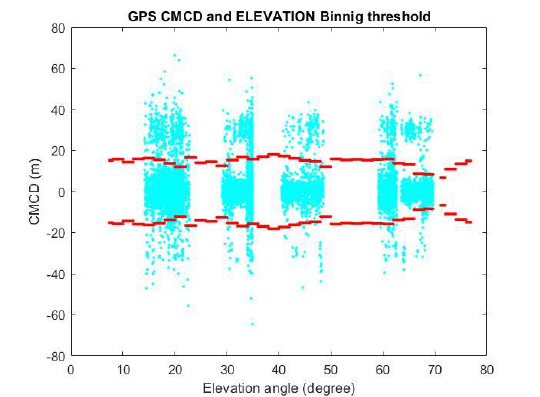
Figure 4. Coloured dots that bigger or smaller values than red values are accepted as GPS CMCD measurements (Cyan dots are GPS CMCDs and red lines are acceptable